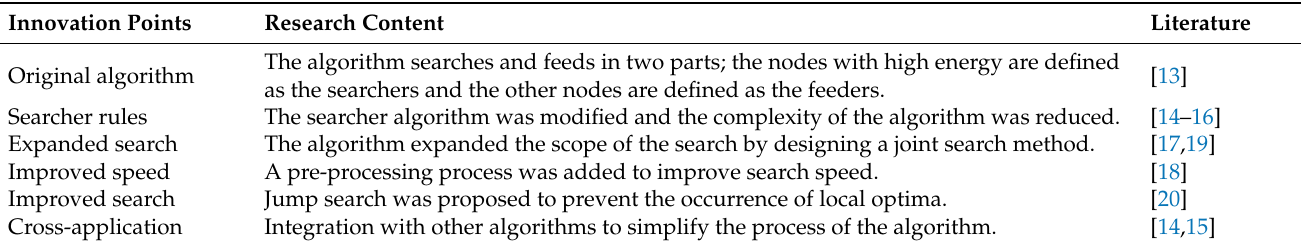
Table 1. Comparison of classical literature on improved sparrow algorithm.